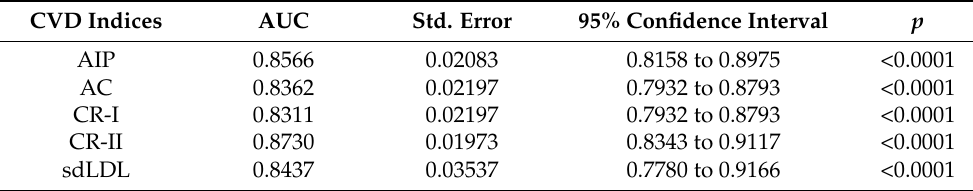
Table 2. The AUC values of plasma sdLDL and of various atherogenic indices.